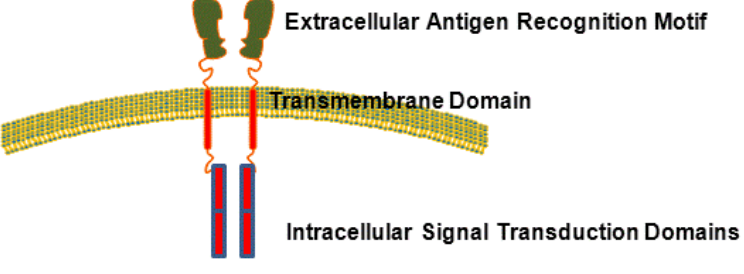
FIGURE 1. Schematic representation of the